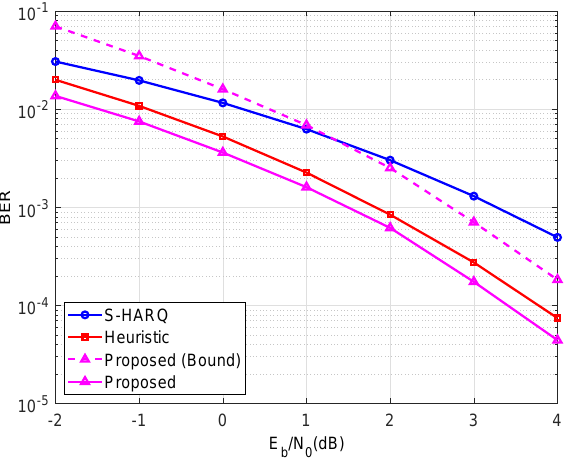
Figure 5. BER comparison of different